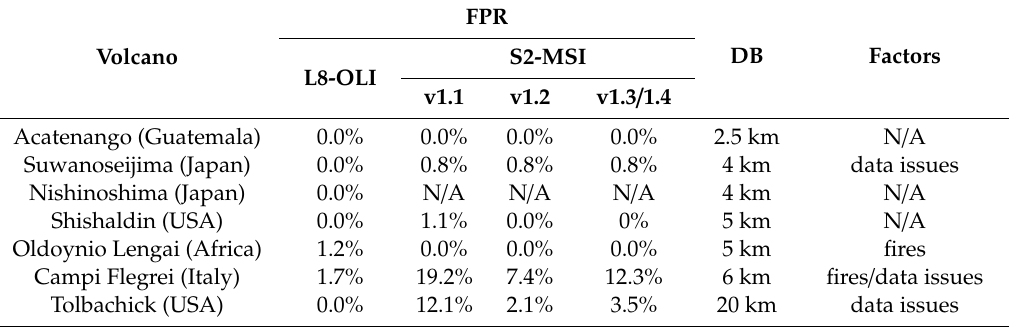
Table 2. False positive rate (FPR) of the di ff erent NHI tool versions estimated from L8-OLI and S2-MSI data of April 2013–May 2020, at a di ff erent distance bu ff er (DB), with indication of factors generating false detections; N / A not